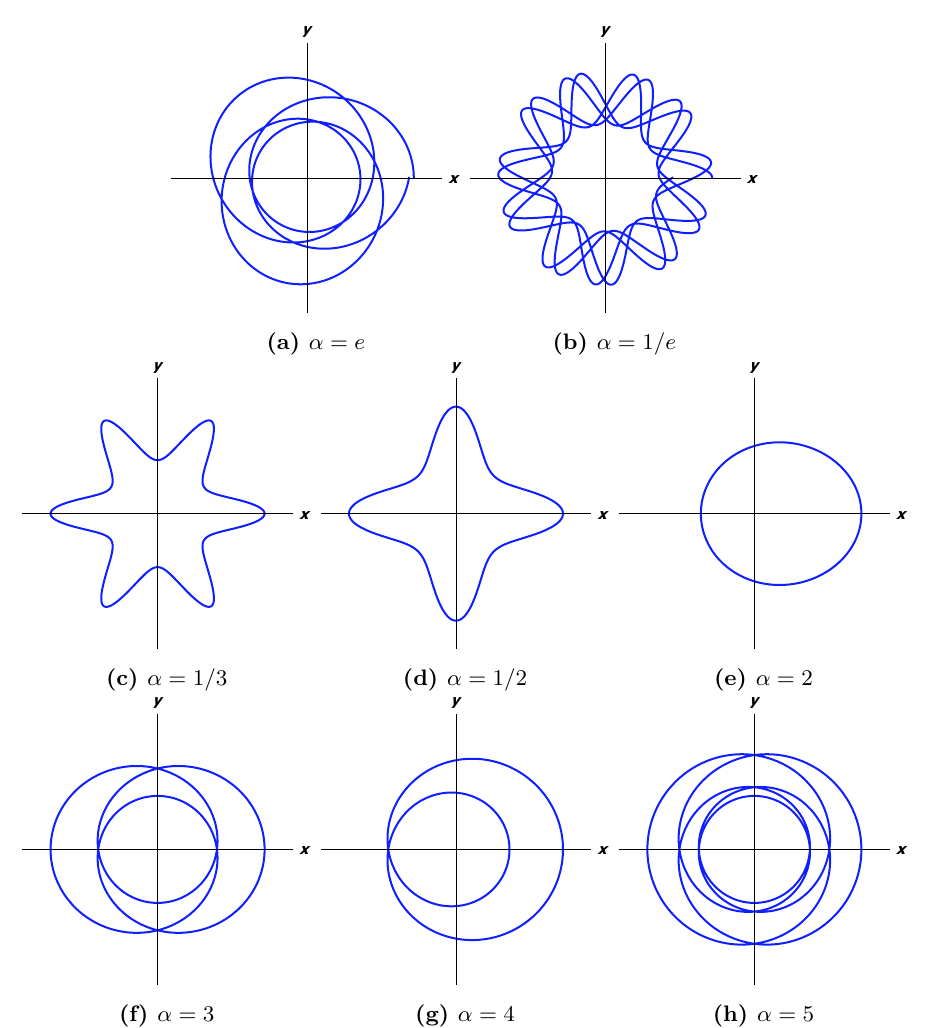
Figure 3. Images of the trajectory for some irrational and rational values of α . From (6.2) one has that r ( ϕ ) = r ( ϕ + αlπ ) , implying that the number of radial minima r the value of α . For α = 1 /k , one has 2 k minima and 2 k maxima. When α = 2 n , there is only one minimum and one maximum of r on the orbit. When α = 2 n + 1 , there are two maxima and two minima, similarly to the case of the isotropic harmonic oscillator in the Euclidean plane. In general case, for α = q/k the number of maxima/minima is N